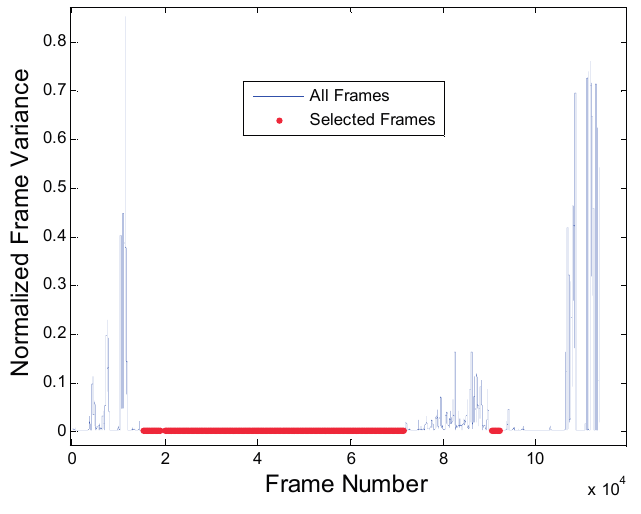
Figure 4. Example of frame selection algorithm